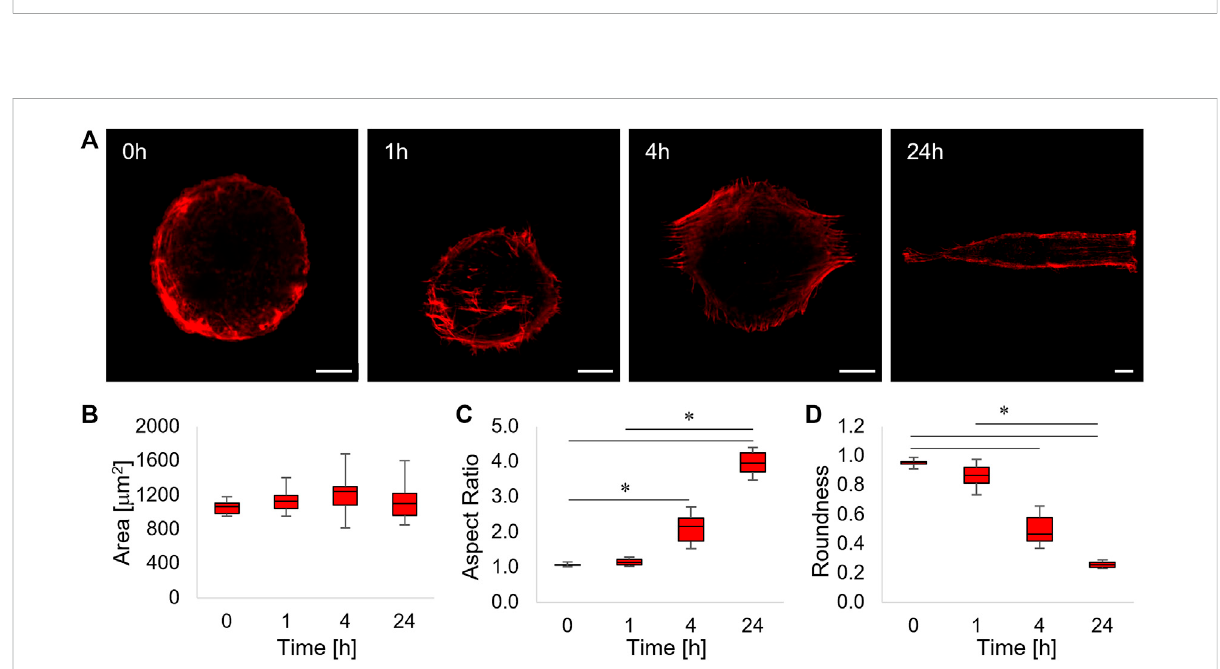
FIGURE 3 (A) Confocal images of phalloidin-stained ASC52telo cells cultivated on the fl at micropatterned pDR1m substrate (0 h) or on pDR1m displaying thetopographicpattern1,4,or24 haftertheinscription. Baris10 μ m. (B) Box-and-whiskersplotofthecellarea, (C) aspectratio,and (D) roundness. The asterisks indicate statistically signi fi cant differences between groups in (C) , whereas they indicate that the median value of the distribution is signi fi cantly different from 45 ° in (D)